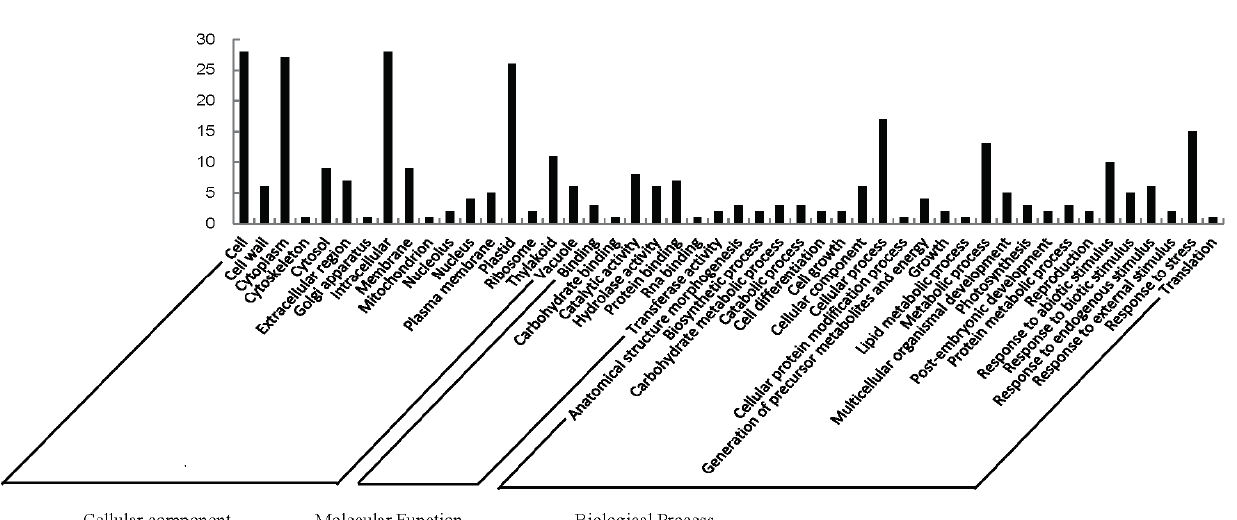
Figure 2. Gene ontology of 21 differentially expressed proteins in labellum and